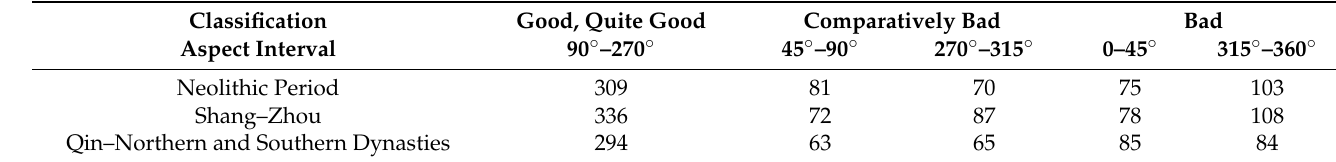
Table 4. Aspect distribution of settlements in different periods.